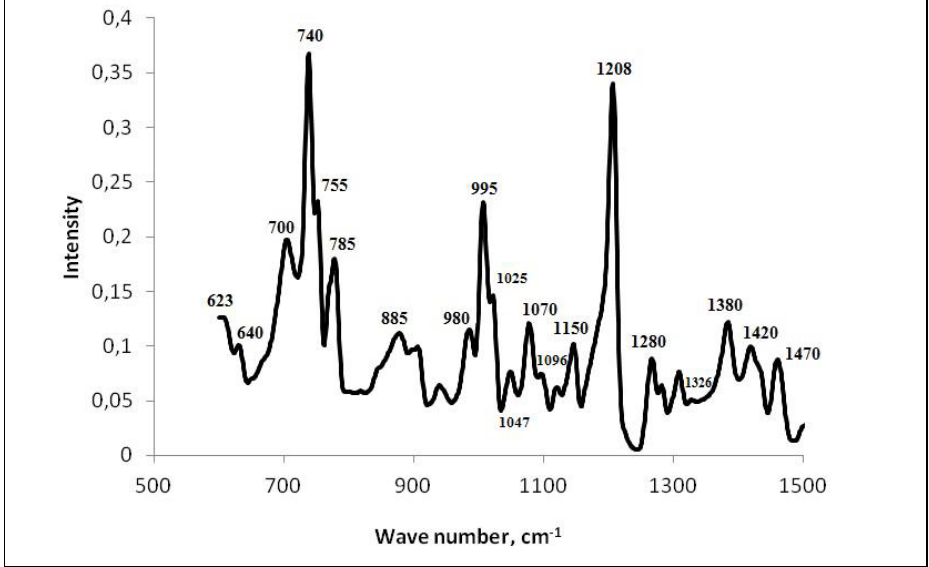
Figure 6. FTIR spectrum of the surface of carbon steel modified in 5 mM aqueous BTA